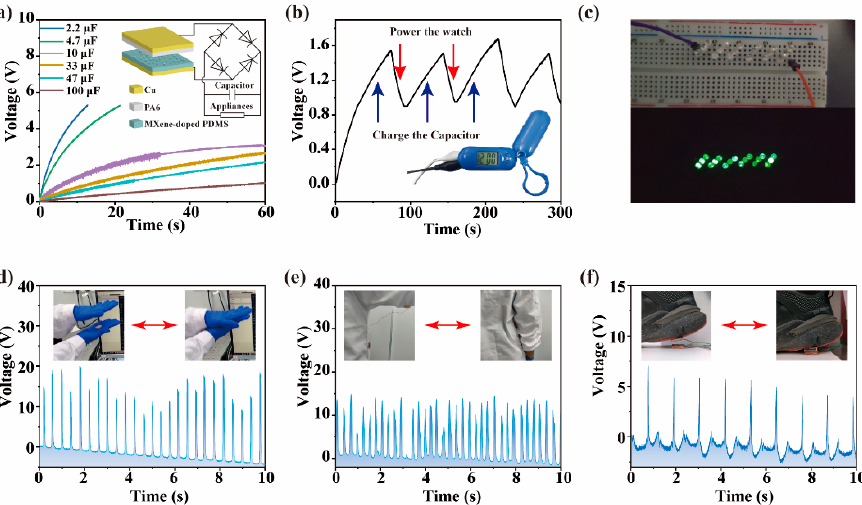
Figure 4. ( a ) Charging curves of the capacitors with different capacitances. The inset is the rectifier circuit using the TENG to drive the load. ( b ) Charging and discharging curve of the 33 μ F capacitor when the MXene-doped LLB TENG is working to power an electronic watch (inset). ( c ) Utilization of the MXene-doped LLB TENG to drive 18 green LEDs. Sensing signals of the body movements with the MXene-doped LLB TENG induced by ( d ) clapping hands, ( e ) flapping arms, and ( f ) up-and-down heel movements.